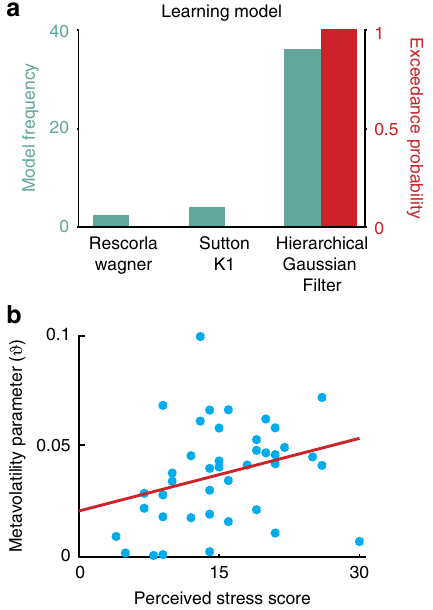
Figure 3 | Assessing models of learning. ( a ) Random-Effects Bayesian Model Comparison confirmed that the Hierarchical Gaussian Filter (HGF) outperformed fixed-learning-rate models (Rescorla–Wagner) and variable- learning-rate non-Bayesian models (Sutton K1). ( b ) Life stress was assessed with a Perceived Stress Scale 38 . Life stress scores were correlated with the metavolatility parameter ( W ) in the HGF, suggesting that more stressed individuals believe the world to be less stable ( n ¼ 41; Spearman r ¼ 0.38, P ¼